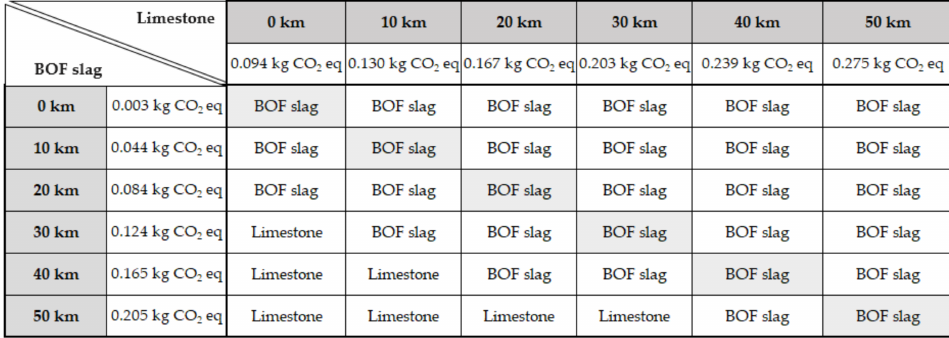
Figure 10. Decision tool comparing limestone and BOF slag as aggregates used in asphalt